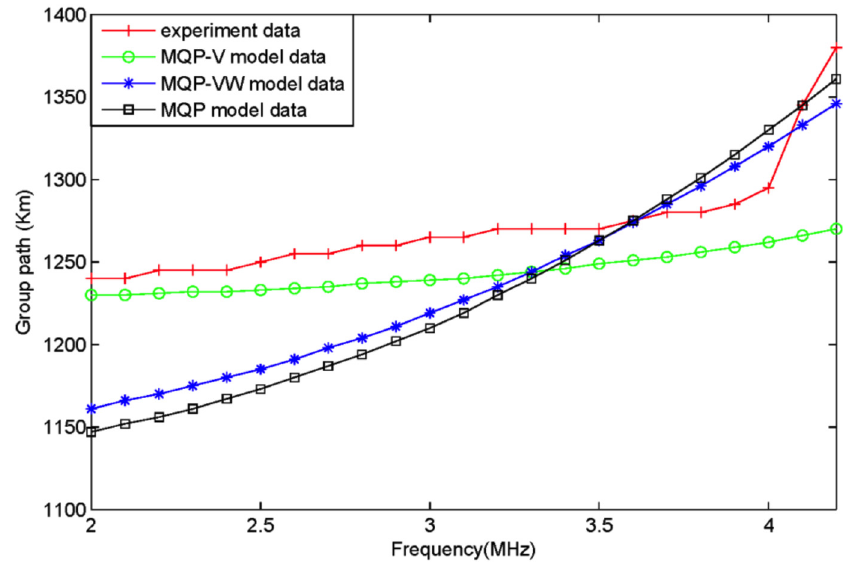
Figure 3. One-hop oblique sounding ionograms generated with the three MQP models and the experimental ionogram. Time: January 3, 2014, at 16:22 (UT).